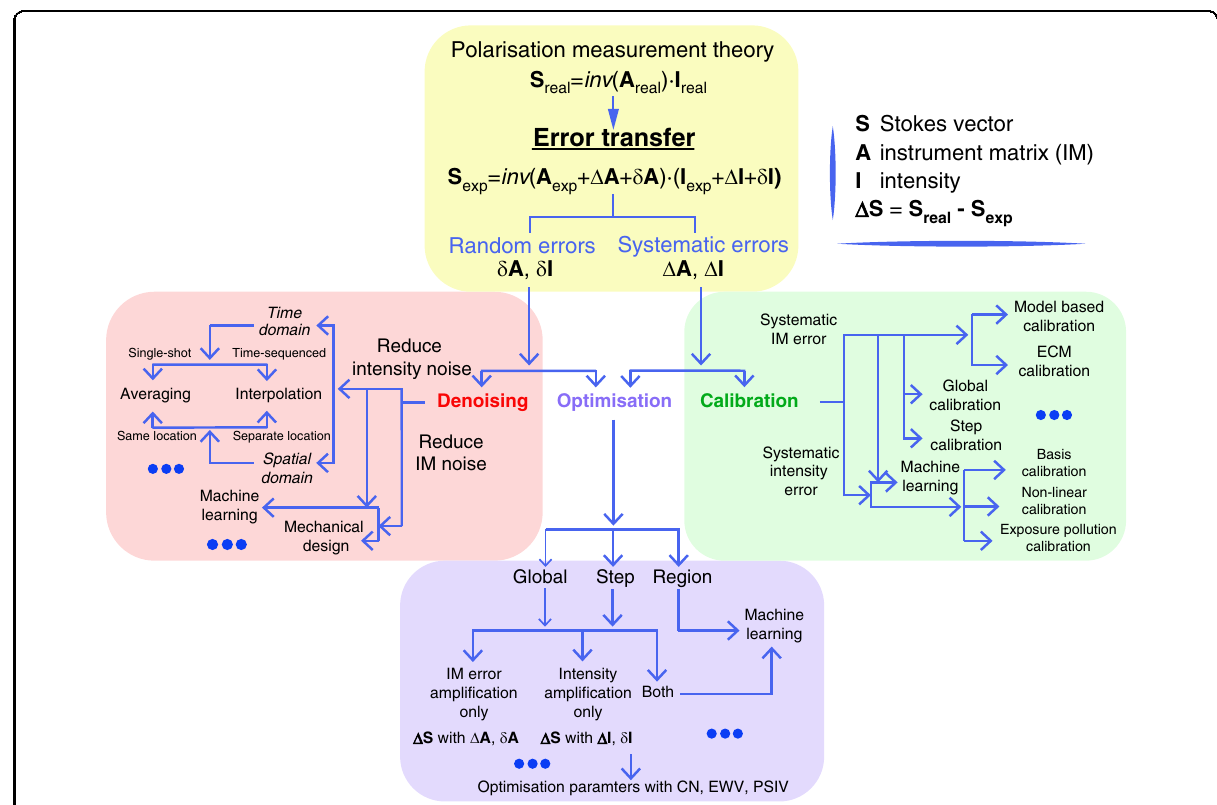
Fig. 4 Polarisation measurement theory for Stokes vectors. The polarisation measurement theory is summarised in three aspects: denoising, optimisation, and